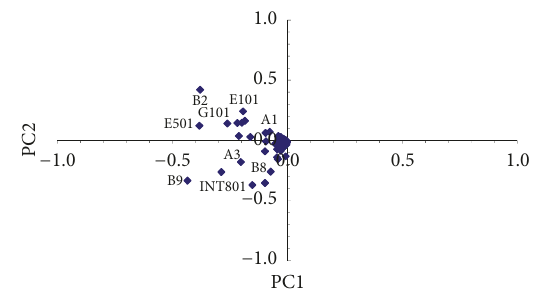
Figure 7: PCA of the total samples and possible heavy metals point